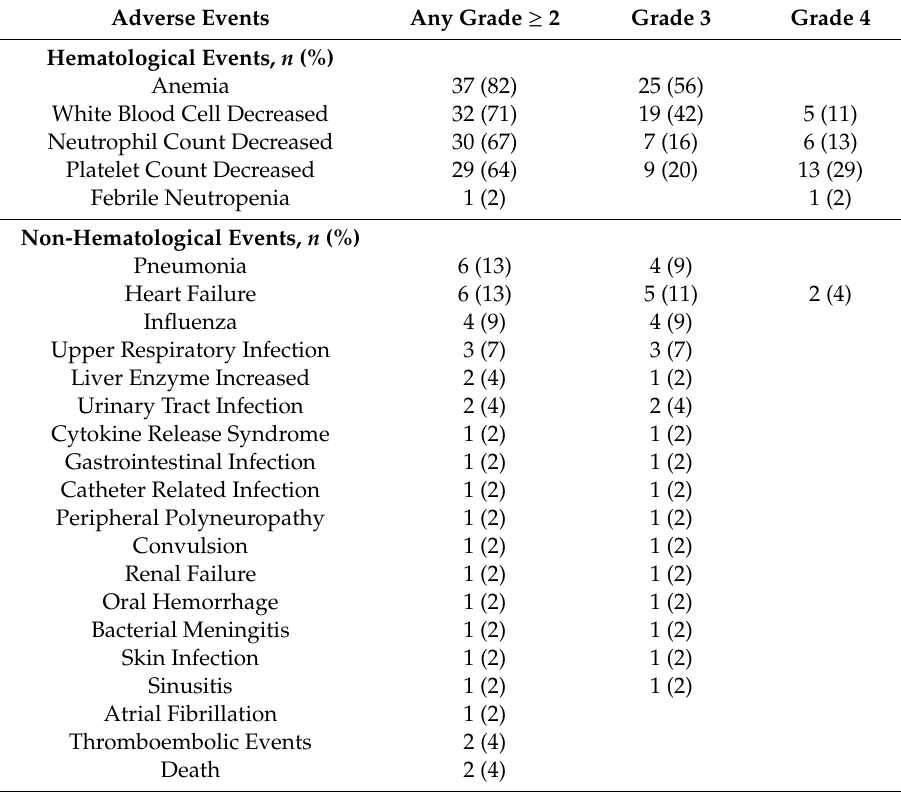
Table 3. Adverse events during